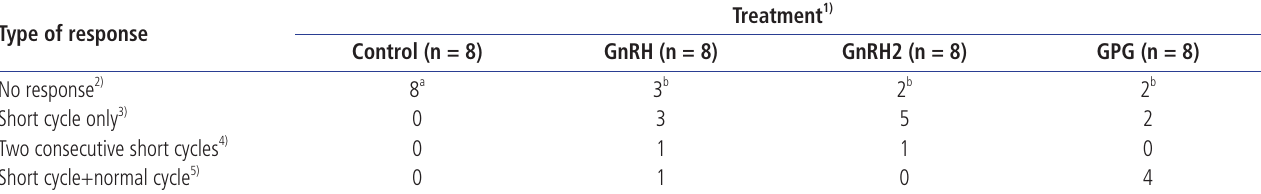
and 7, and with 10 mg of PGF2 α on day 6. 2) P4 concentrations never increased above 0.75 ng/mL.